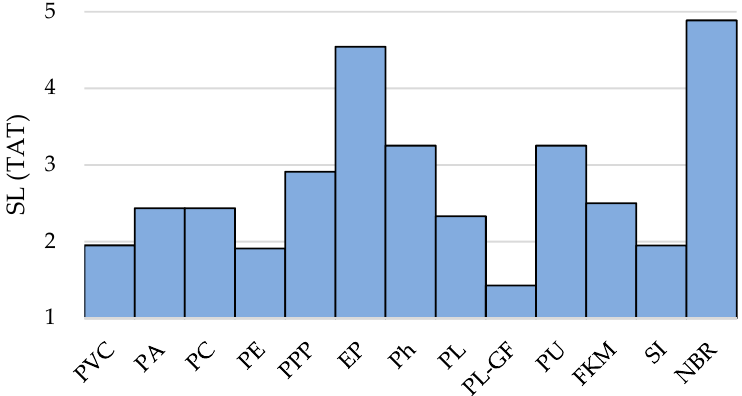
Figure 5. Thermal aging tolerance (TAT) in terms of stringency level values.